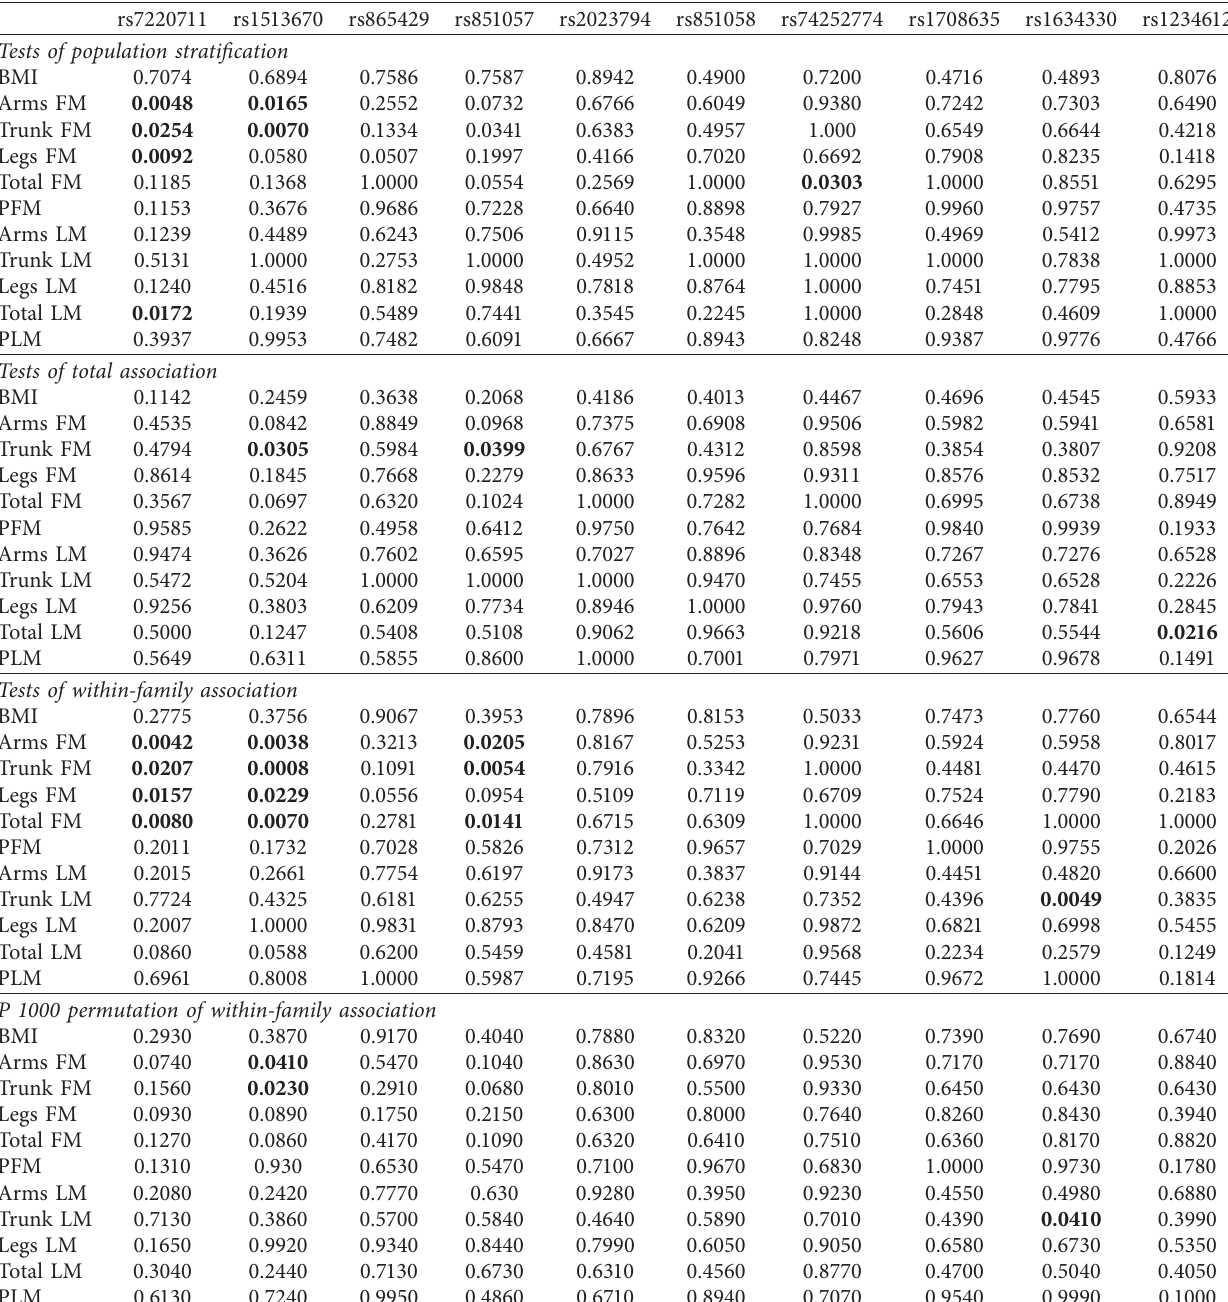
Table 5: P values of tests for population stratification, total association, and within-family association in SOST tag SNPs using